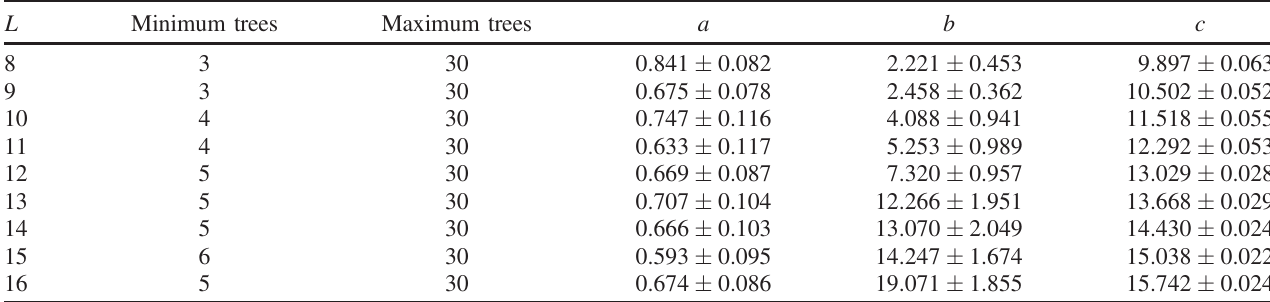
TABLE IV. Fit to ax − 3 þ bx þ c − 4 ð a 3 b Þ 1 = 4 = 3 3 = 4 for the median results of the logical-planted instances using HFS with y ¼ log TTS . The factor c does not include τ and x ¼ log n trees